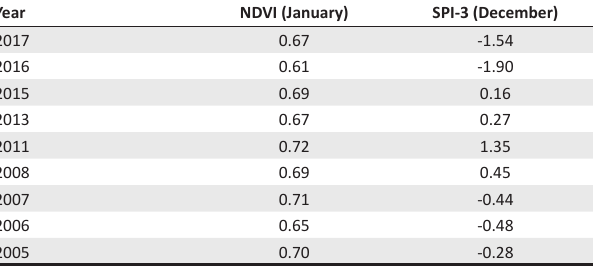
0.6000.700 0.6500.710 0.670 0.660 0.670 FIGUR E 4: Lowest MODIS NDVI (Terra) (MOD44 16 days) for the month of January for 2000–2018. TABLE 3: Normalised Difference Vegetation Index and Standard Precipitation Index for selected drought years.